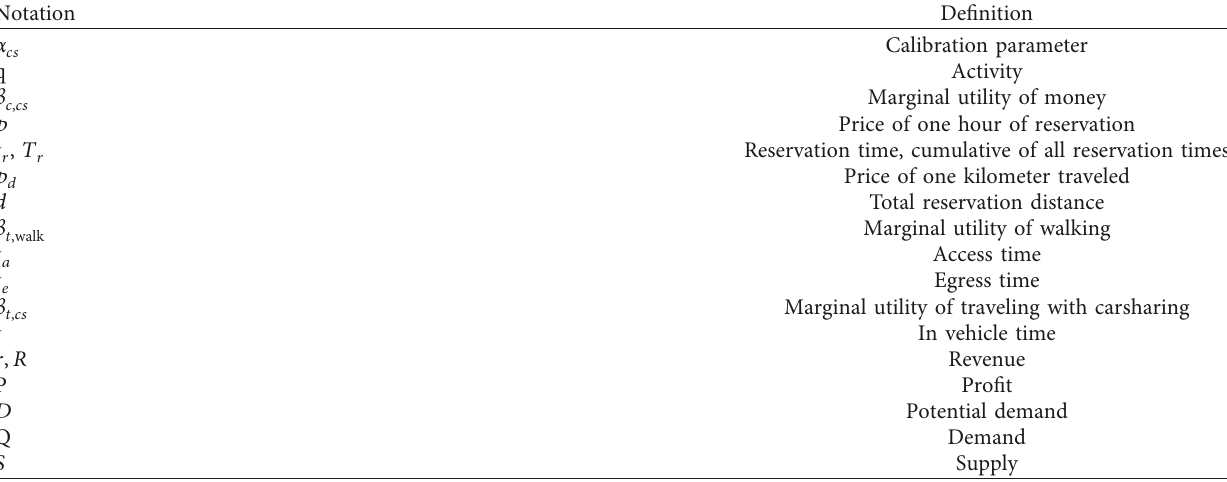
Table 1: Notation.